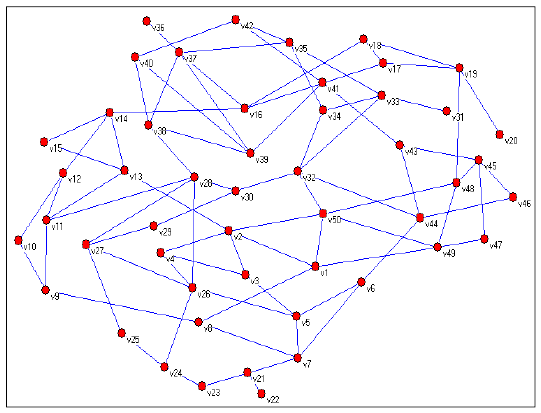
Figure 9. Local topology of the Beijing power communication network.